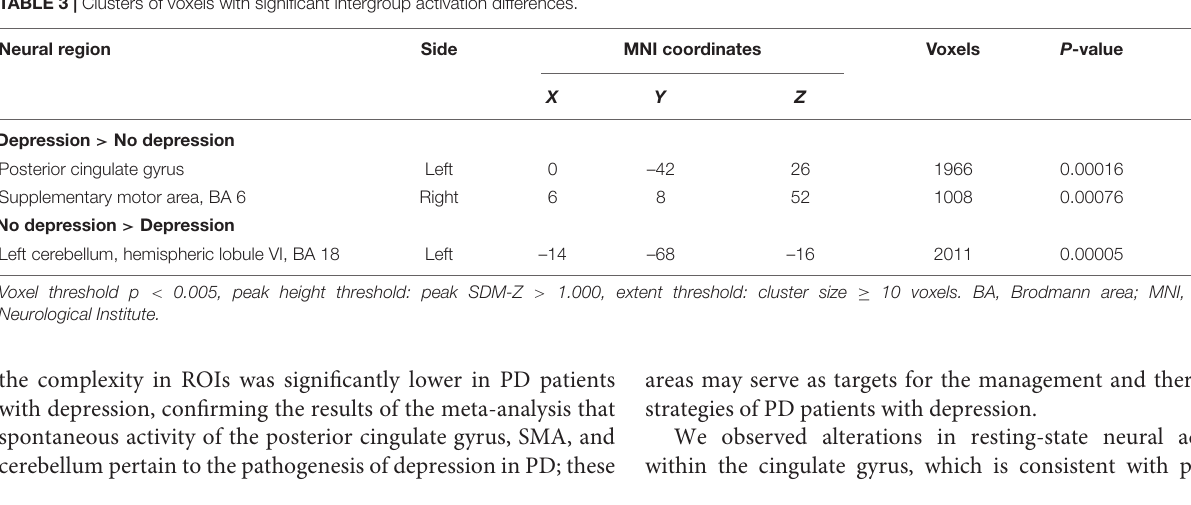
TABLE 3 | Clusters of voxels with significant intergroup activation